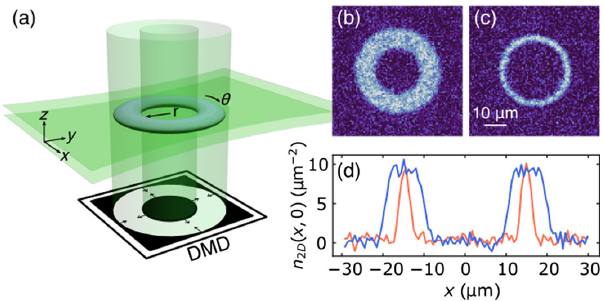
FIG. 1. Tunable homogeneous rings with ultracold fermionic superfluids. (a) Sketch of the experimental setup. A blue-detuned TEM 01 -like beam propagates horizontally and provides a tight harmonic trap in the vertical z direction, whereas a DMD-made repulsive potential sculpts a tunable ring-shaped boxlike confine- ment in the x - y plane. The latter is imaged onto the atomic cloud by a high-resolution microscope objective, omitted in the figure. (b,c) In situ images of a unitary Fermi superfluid confined in two ring geometries with different radial thickness, comprising around 7 . 5 × 10 3 and 2 . 7 × 10 3 fermion pairs, respectively. The images correspond to a single experimental acquisition of the atomic density. (d) Density cuts along the y ¼ 0 diameter of the rings in panels (b) and (c) are shown as blue and orange lines, respectively, obtained by averaging over 20